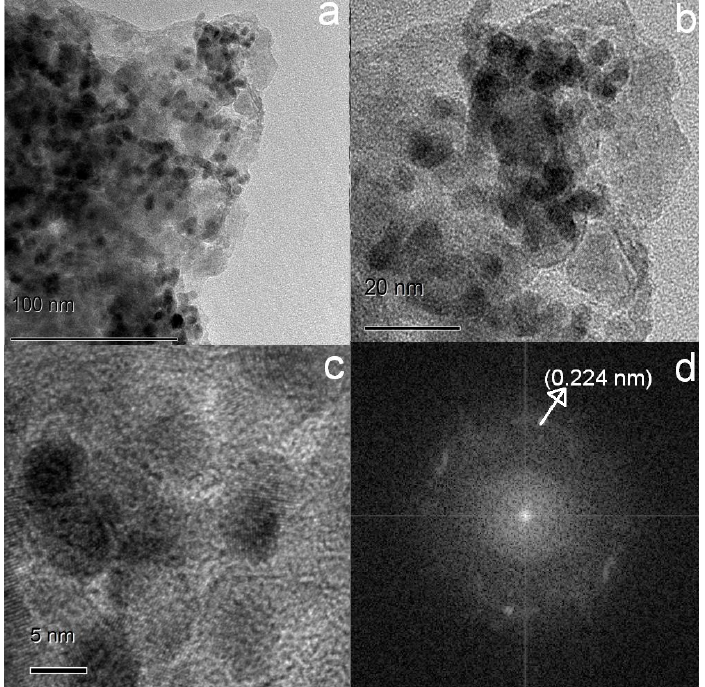
Figure 3. (HR)TEM micrographs of spherical (s) Pd NPs: ( a , b ) overview; ( c ) HR-TEM; and ( d ) FFT